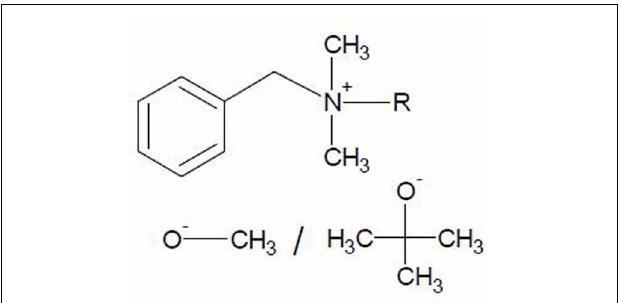
FIGURE 1 | Synthesizedalkalineionicliquids,benzalkoniummethoxide ([ADBA][MeO])andbenzalkoniumtert-butoxide([ADBA][tBuO]). Alkyl distributionfromC 8 H 17 toC 16 H 33